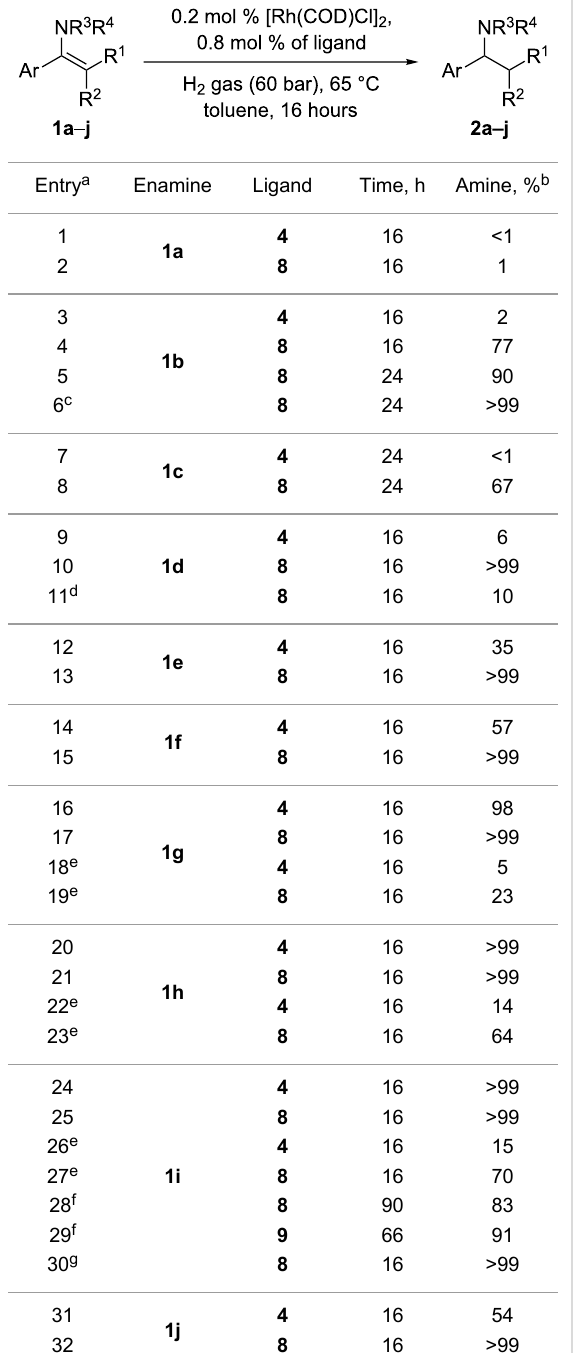
Table 1: Hydrogenation of enamines with Rh catalysts of PPh 3 vs ligand 8 .